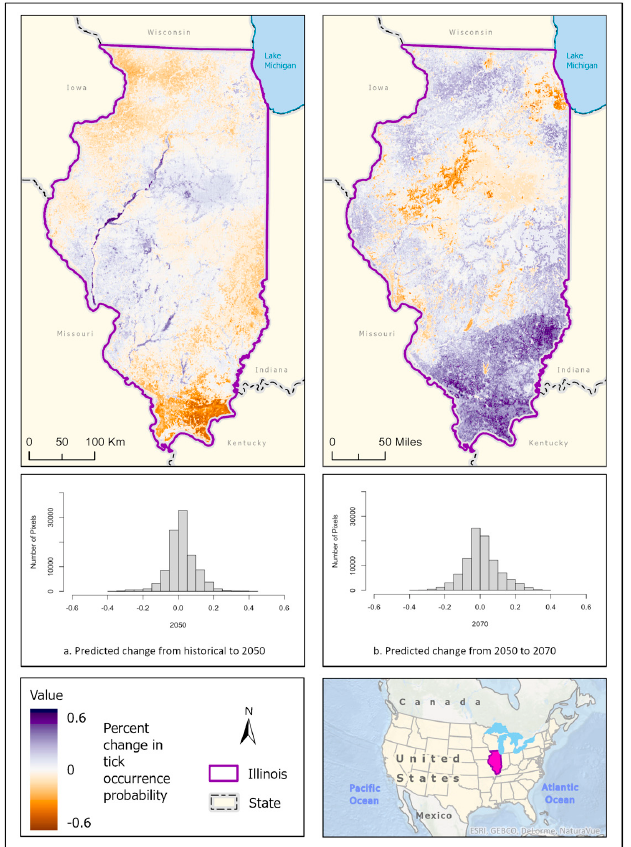
Figure 3. Percent change in the likelihood of I. scapularis occurrence between the historical climate and 2050 ( left ) and from 2050 to 2070 ( right ). Red shades indicate a reduced likelihood of occurrence (negative change), and blue shades indicate an increased likelihood of occurrence (positive change). The histograms represent the number of pixels (y − axis) containing the binned percentage likelihood change (x − axis) of I. scapularis suitable habitat across the map. Inset map indicates the location of Illinois within the United States/North America.